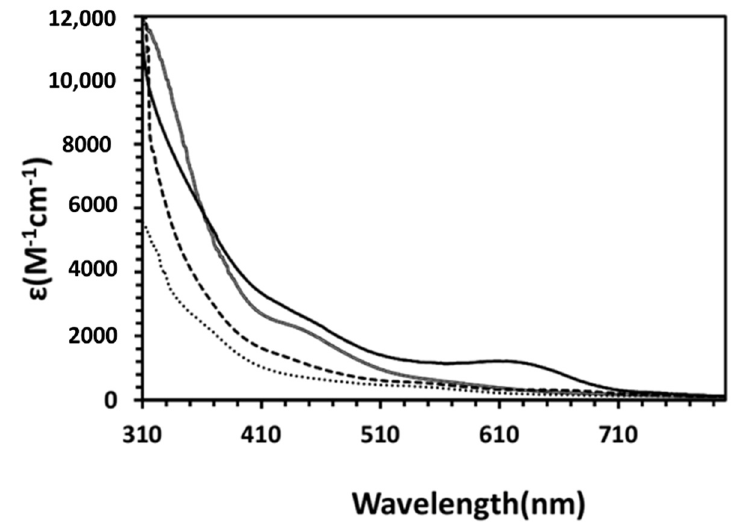
Figure 7. UV–vis absorbance spectra of the Pt NHase (compound) wildtype, (solid) α Cys108Ser, (dashed) α Cys108His, and (dotted) α Cys108Met in 50 mM HEPES pH 7.0 at 25 °C.